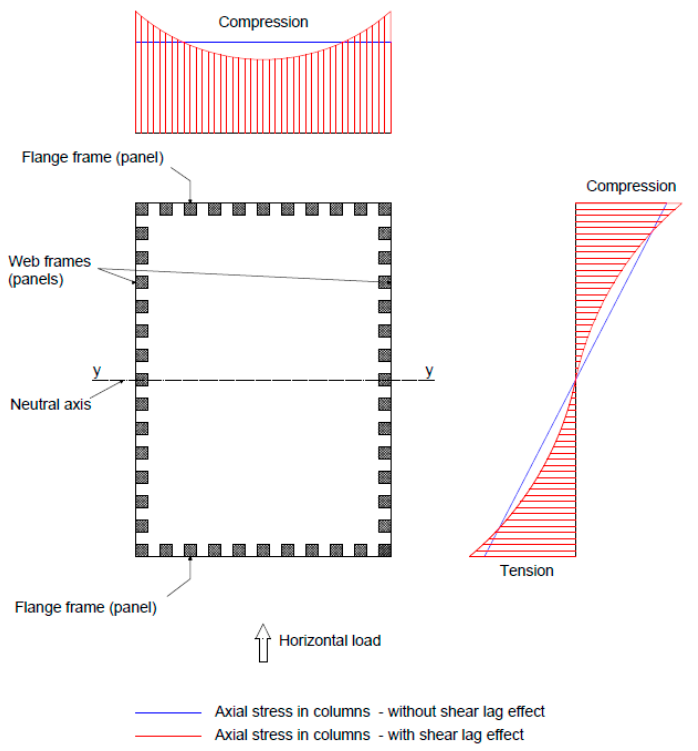
Figure 1. Shear lag effect in a tube structural system (positive shear lag effect).